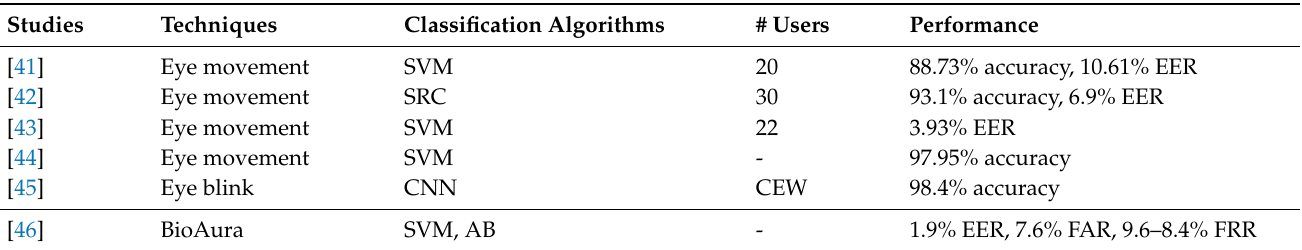
Table 8. Eye-movement-based authentication.